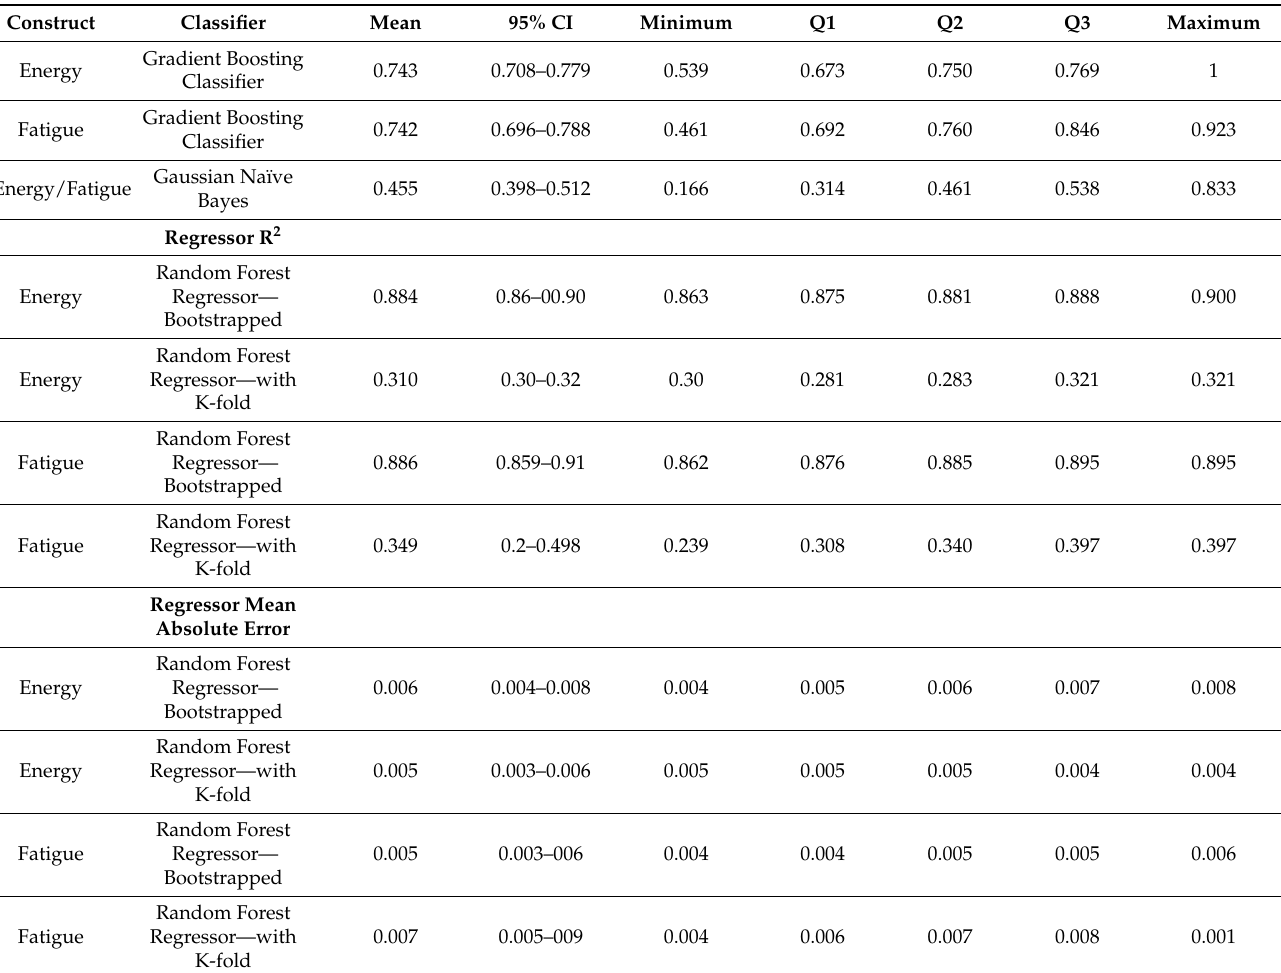
Table 4. Best classifier and regressor